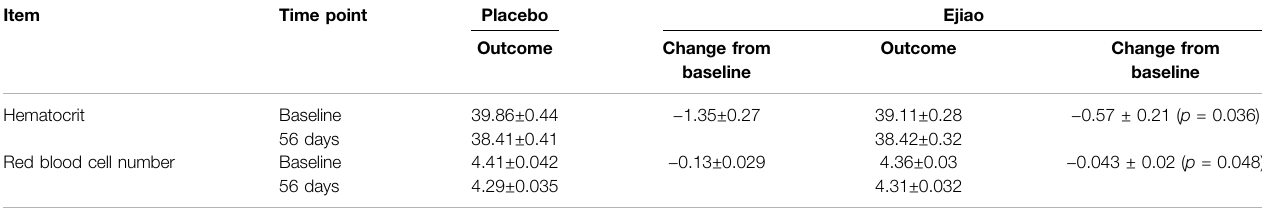
TABLE 3 | The changes of hematocrit and red blood cell numbers from the baseline over 56 days of treatment with Ejiao. Item